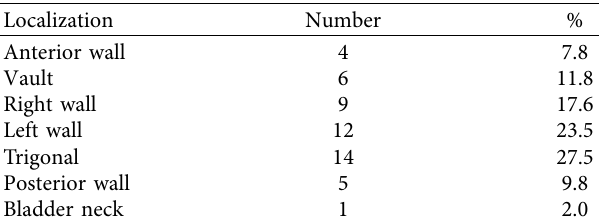
Table 3: Cumulative distribution of tumors at endoscopy.